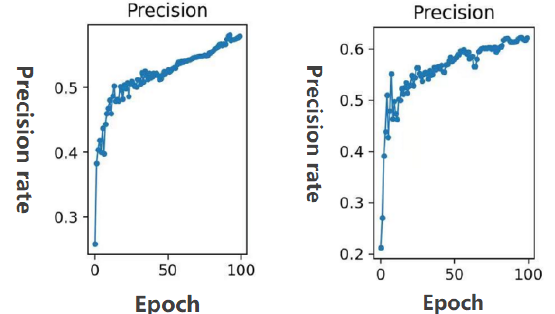
Figure 12. Precision comparison between YOLOv3 with auxiliary network and the method in this paper.The precision of the YOLOv3 model with auxiliary network on the left, and the precision of the improved model in this paper on the right. (The horizontal coordinate is the number of epochs and the vertical coordinate is the precision